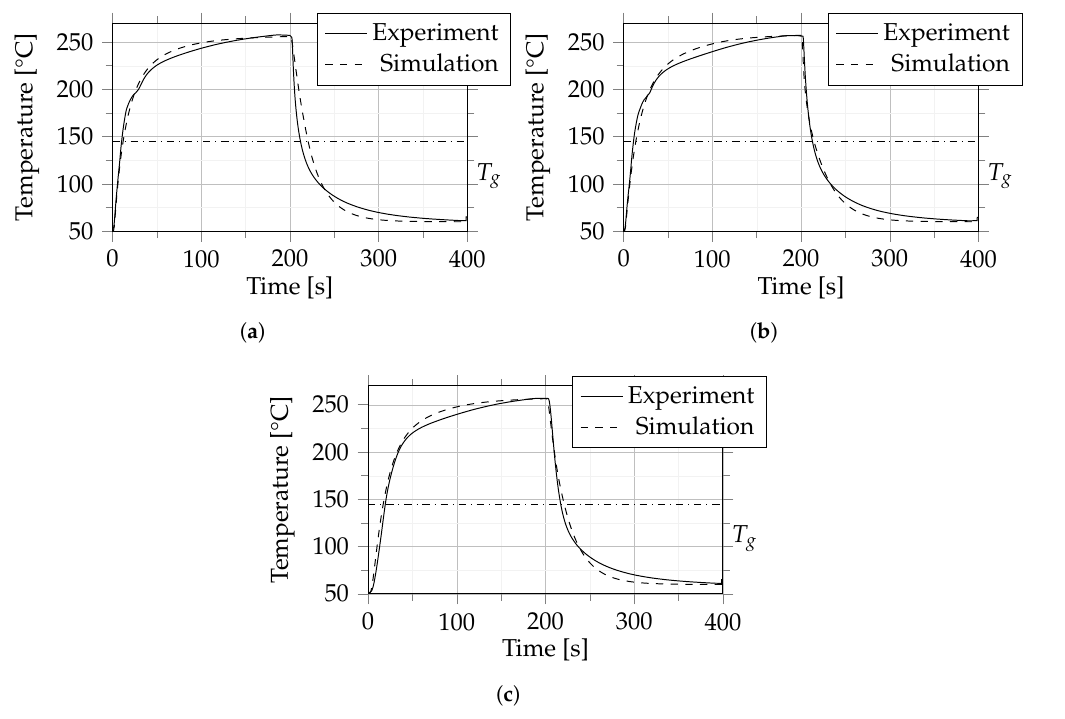
Figure 12. Case 3: Comparison between experiment and simulation in terms of temperature between layers 1 and 2 ( a ), 9 and 10 ( b ) and 17 and 18 ( c ). The dash-dotted line indicates the glass transition temperature ( T g ) of 145 °C.